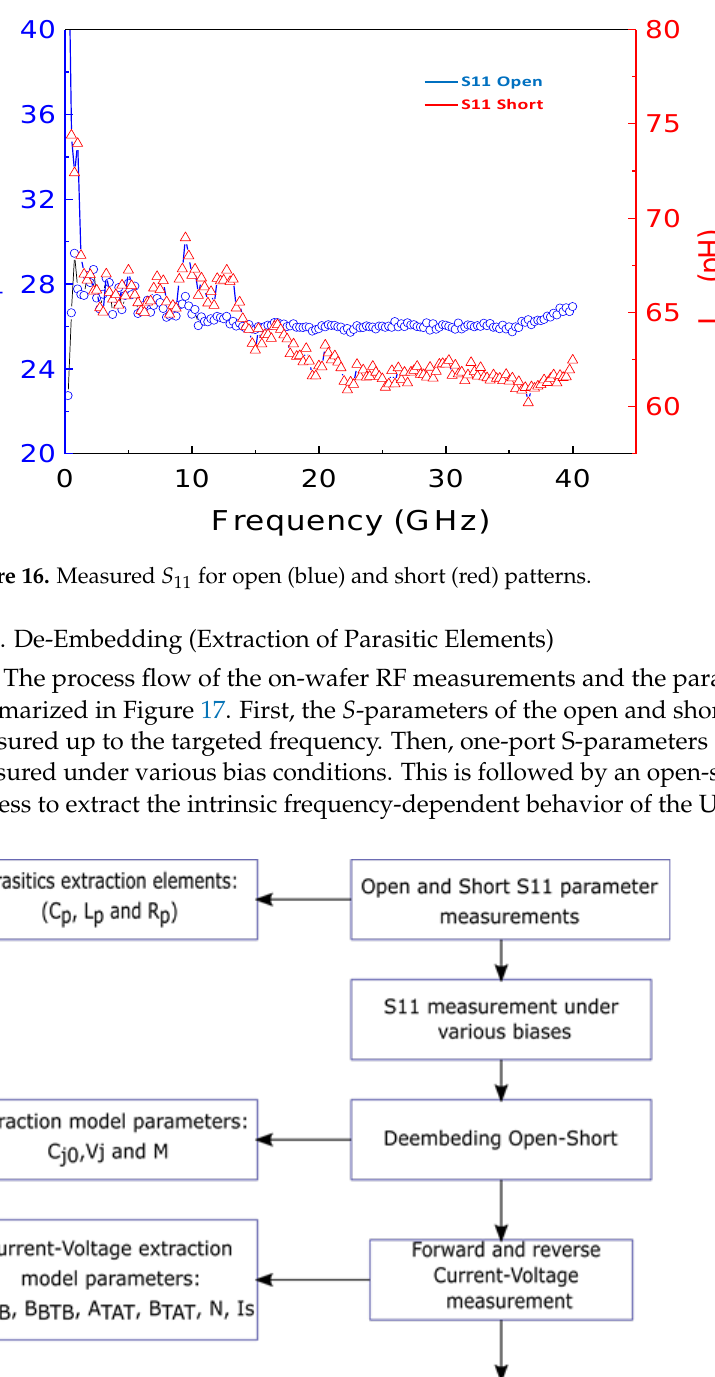
Figure 15. RF test structures with Ground-Signal-Ground (G-S-G) pads: ( a ) open and ( b ) short.